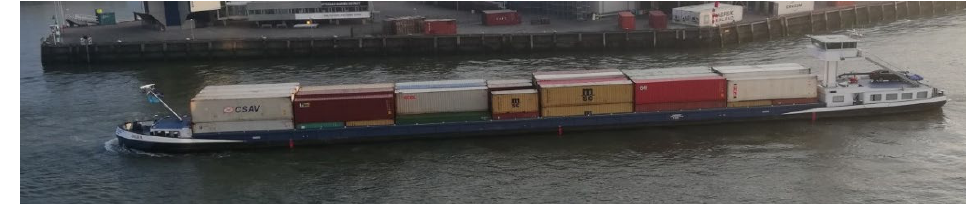
Figure 5. About 80 TEU can be transported by inland waterway transport mode